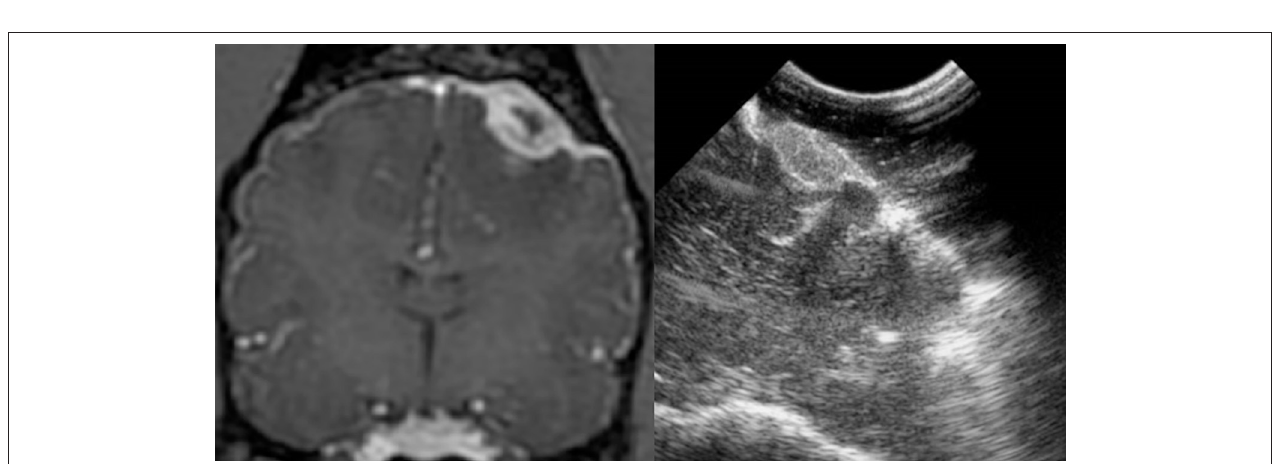
FIGURE 3 | Case 13. There is a small, 0.74 × 1.0cm (MRI)/0.73 × 1.1cm (US), ovoid, well-circumscribed, heterogeneous mass present in the periphery of the parietal lobe, which is hyperechoic to the remaining brain parenchyma and displays a strongly hyperechoic rim. This mass was a meningioma.